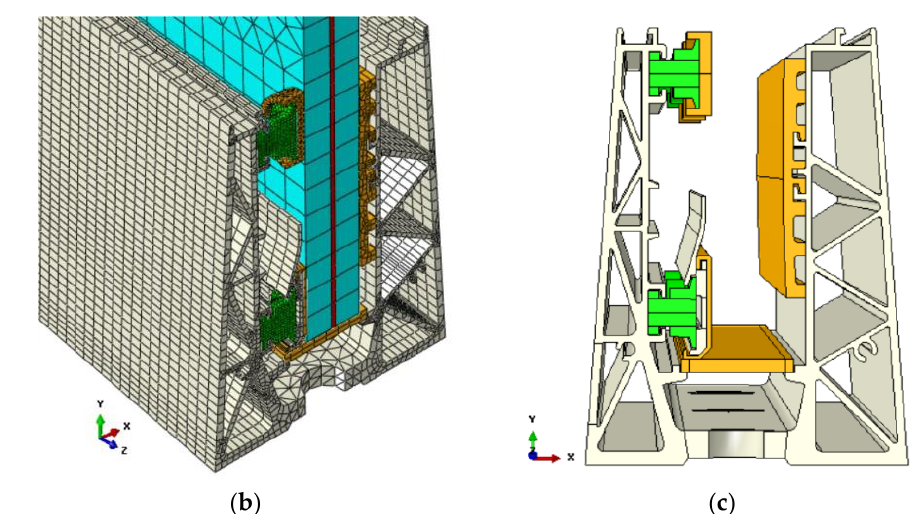
Figure 3. Example of full 3D FE numerical model of a laminated glass balustrade a with linear base metal restraint (ABAQUS): ( a ) axonometric view of the half balustrade assembly and ( b ) detailed view of the base restraint region, with ( c ) a cross-section of the metal fixing system (glass panel and mesh pattern hidden from section view).